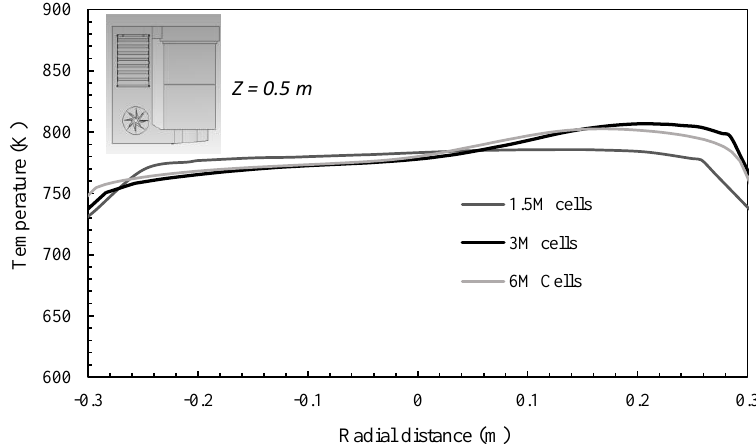
Figure 6. Temperature profile at a horizontal line located in the middle of the workspace for the three di ff erent meshes studied at 990 rpm.